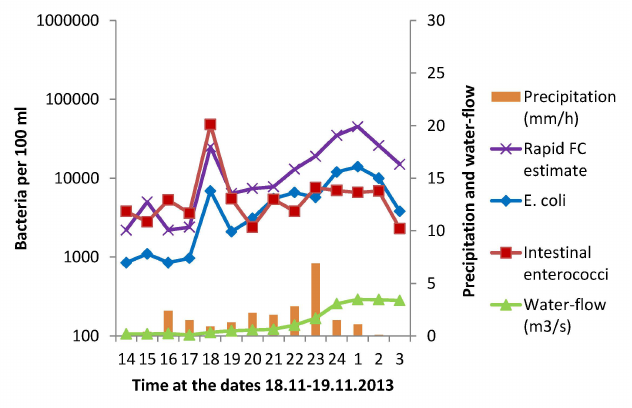
Figure 3. Fecal indicator bacteria and water-flow in the Ljanselva River before, during and after rainfall on 18 November